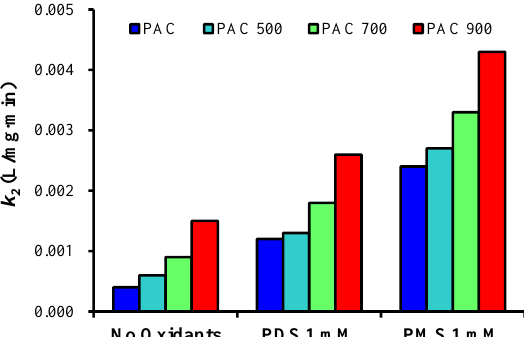
Figure 1. The pseudo second-order reaction constants ( k 2 ) of OTC removal in the absence of an oxidant and in the presence of 1 mM PDS or PMS (PACs 0.1 g/L, OTC 25 mg/L, initial pH 6.0, 20 ± 2 °C).